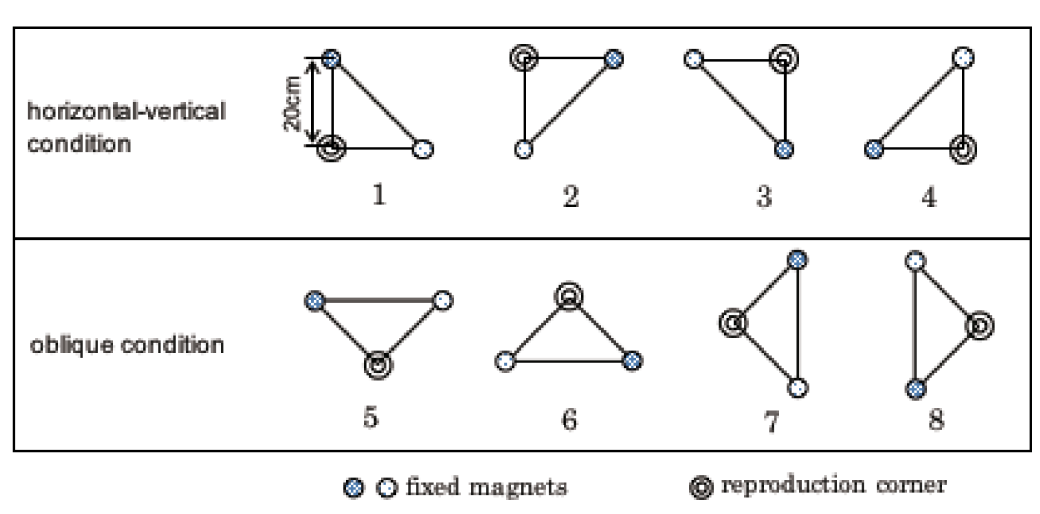
Fig 1. A schematic diagram of the 8 layouts used in the experiment. For each layout, the right angle corner was the corner which the participant reproduced.